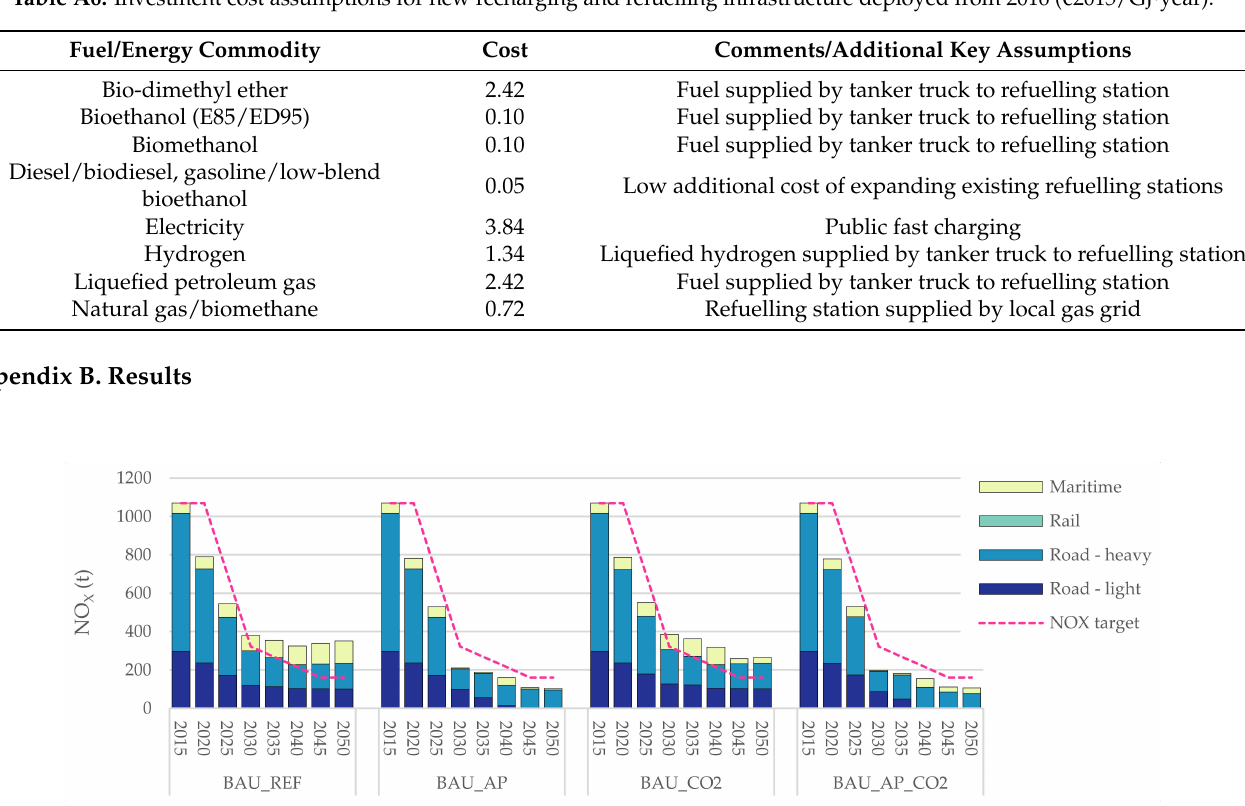
Figure A1. By-mode tailpipe emissions of nitrogen oxides (NO X ) in the Business-as-usual scenarios (t). Note : Road—heavy = buses, MGVs and HGVs; Road—light = cars and LCVs.